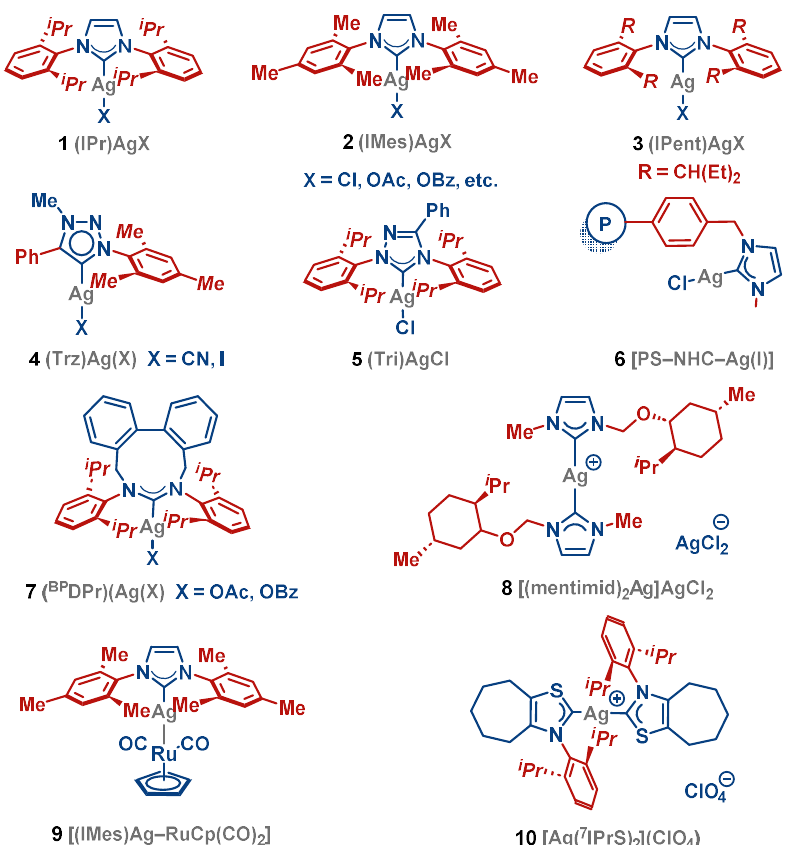
Figure 1. Structures of the most common Ag–NHC complexes used in π-functionalization of